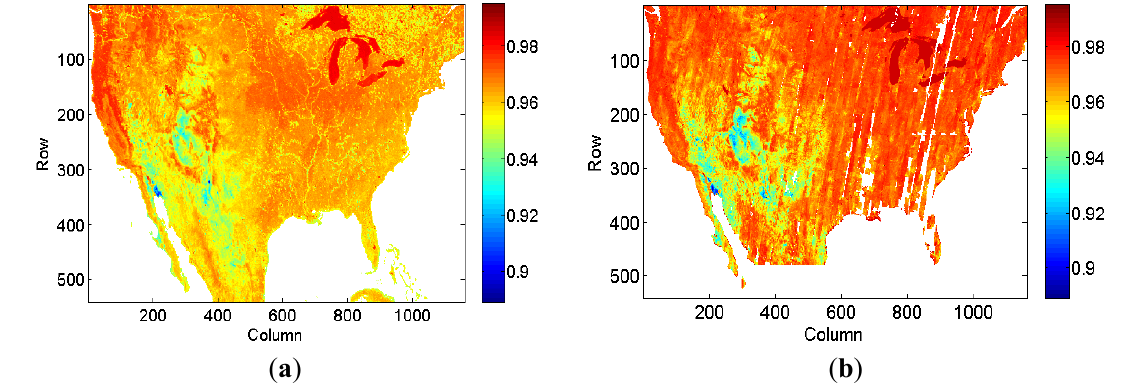
Figure 3. Comparison between NAALSED BBE and UWIREMIS BBE for the summer season. ( a ) UWIREMIS BBE; ( b ) NAALSED BBE; ( c ) the difference between UWIREMIS BBE and NAALSED BBE; ( d ) the histogram of the